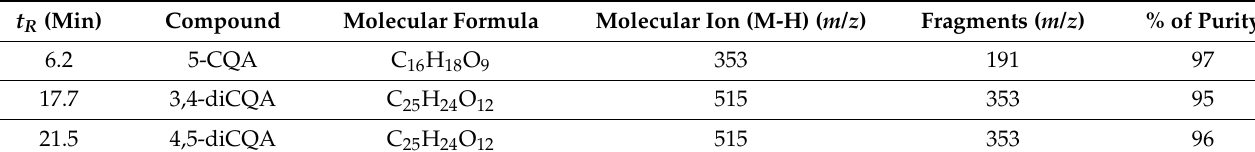
Figure 1. Total polyphenolic content (TPC), 5-CQA, 3,4-diCQA and 4,5-diCQA concentrations measured in 3 size of Mex- ican PSP: large (PSP-L), medium (PSP-M), and small (PSP-S). Each bar is the mean accompanied of the mean value ± SD of three independent experiments.